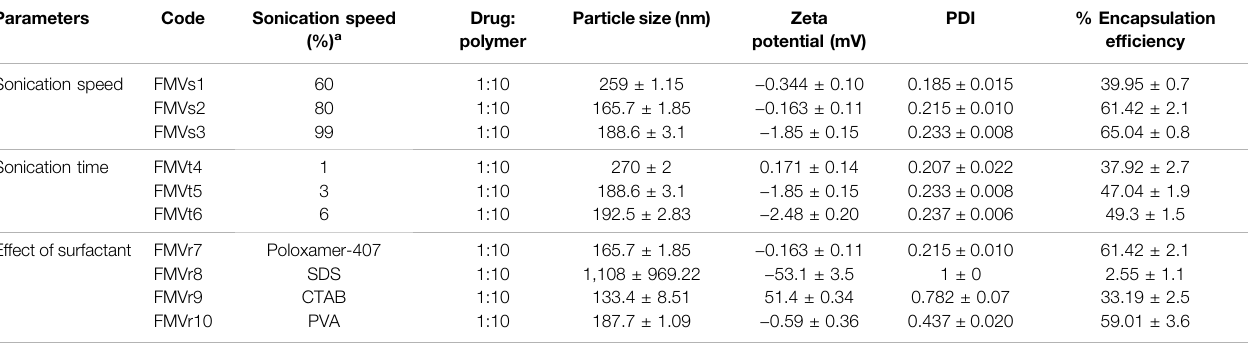
TABLE 3 | Effect of sonication speed and sonication time on particle size and encapsulation ef fi ciency. Parameters